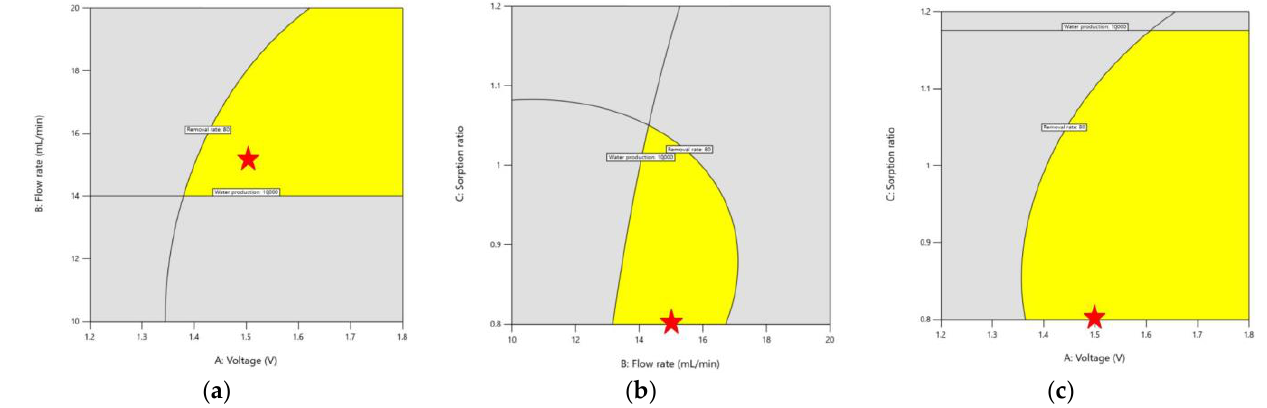
Figure 9. Contour overlay plots showing the graphical optimization of the CDI (yellow area: conditions for meeting the water reuse criteria, grey area: conditions failing to meet the criteria, star marks (asterisks): proposed optimum conditions). ( a ) TDS removal vs. voltage and flow rate; ( b ) TDS removal vs. voltage and sorption ratio; ( c ) TDS removal vs. flow rate and sorption ratio.